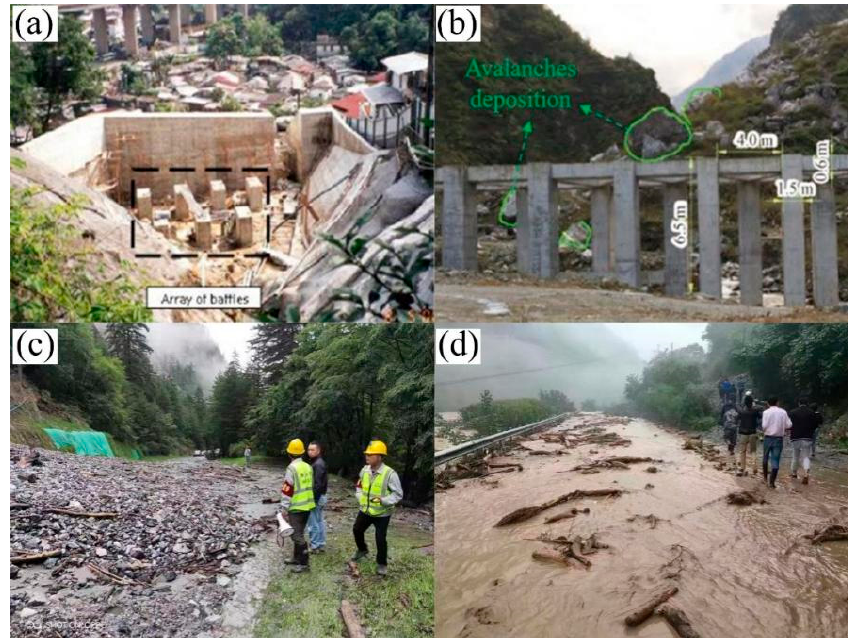
Figure 2. The existing baffles and mudslide hazards in natural landscapes: ( a ) array of baffles in Hong Kong [20], ( b ) array of baffles in mainland China [21], ( c ) damage to the landscape from the Jiuzhaigou mudslide disaster (https://www.jiuzhai.com/news/scenic-news/6686-2019-07-22-10-37-47 (accessed on 22 July 2019)), and ( d ) damage to roads from the Jiuzhaigou mudslide disaster (http://news.huaxi100.com/show-226-799121-1.html (accessed on 23 July 2016)).